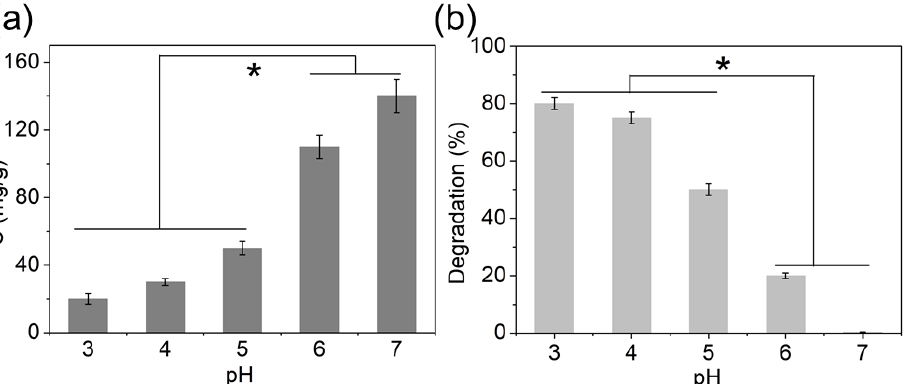
Figure 7. Effect of pH on ( a ) Pb 2+ adsorption capacity (50 mg/L of Pb 2+ , 200 mg/mL of adsorbent, 1 mL solution, room temperature, 30 min of incubation time) and ( b ) the stability of magnetic MIL- 68(Ga) (200 mg/mL of adsorbent, 1 mL solution, room temperature, 30 min of incubation time). The asterisks (*) indicate significant difference between the groups ( p < 0.05).